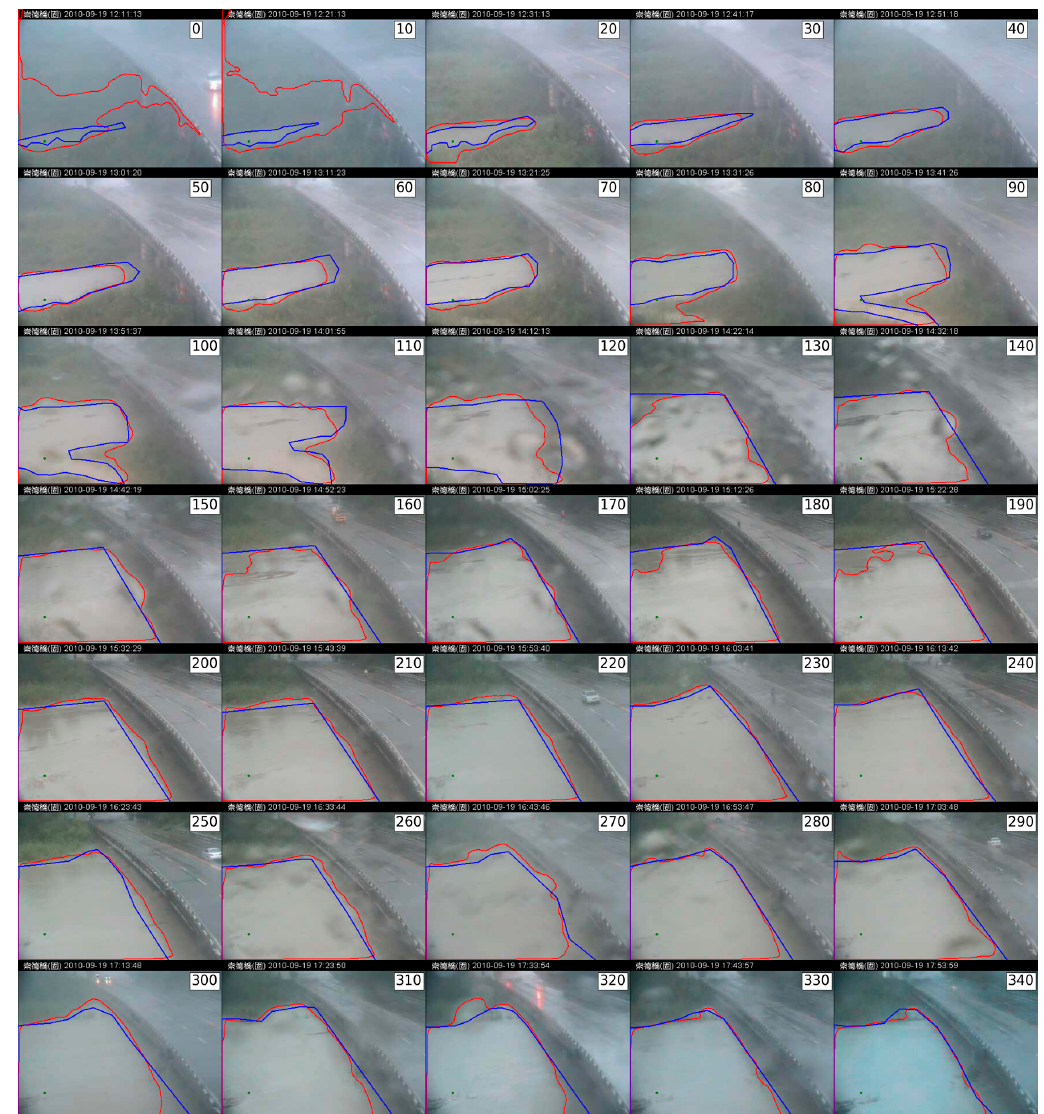
Figure 13. Part GrowCut’s results with red segments from growing methods. The blue line is the ground truth, and the green marker is the initial seed for the growing methods. Most flood segmentation failures occurred during heavy rain and fog. GrowCut is robust to raindrop stains on the CCTV screen. (Note: The Traditional Chinese in header of all images is represented the location in the Changed Bridge except).